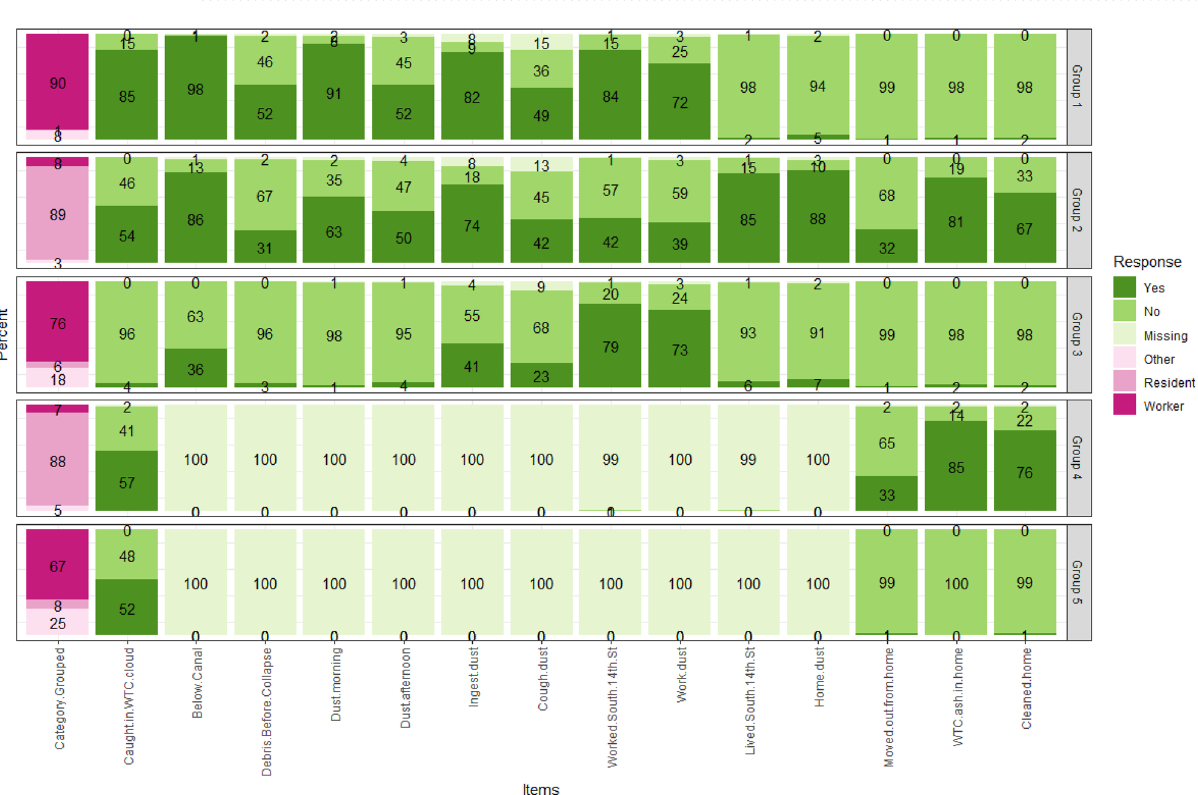
Figure 1. Patient flow diagram. ‘Acceptable’ means that the patients had all spirometry/oscillometry measures used in the analyses. LCA: latent class analysis.